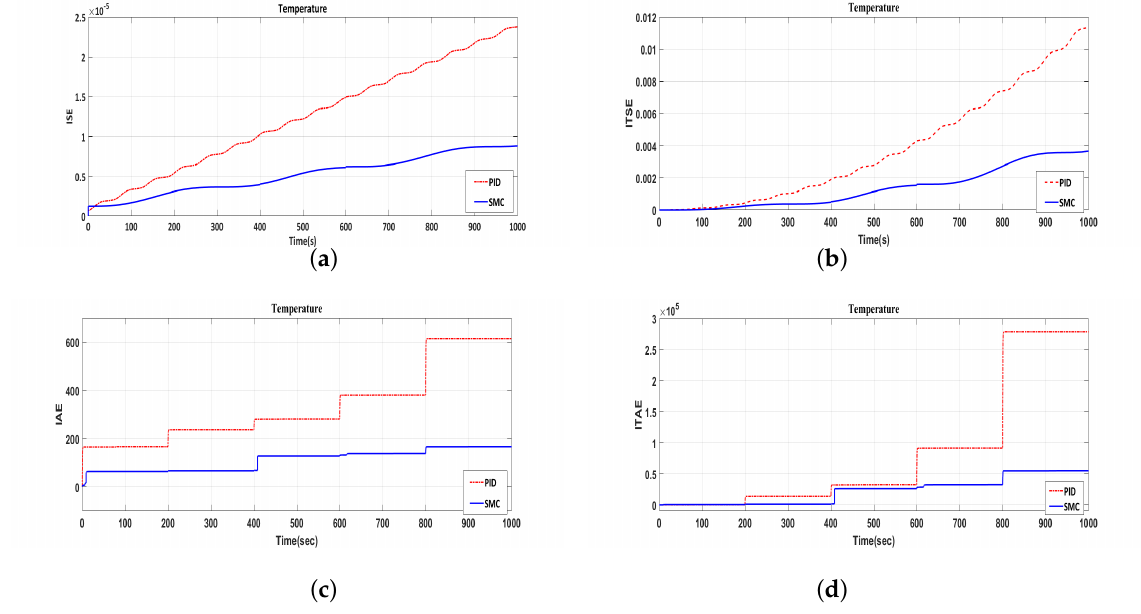
Figure A1. Performance indices, ( a ) square of the error (ISE), ( b ) integral of time into squared error (ITSE), ( c ) integral absolute error (IAE) and ( d ) integral time absolute error (ITAE) graph for temperature output of the first reference signal, sequence of